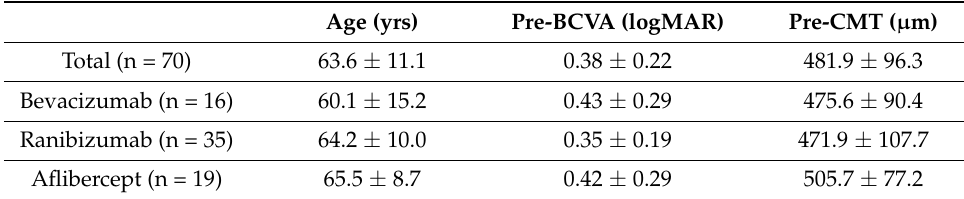
Table 1. Baseline demographics of patients. Age (yrs) Pre-BCVA